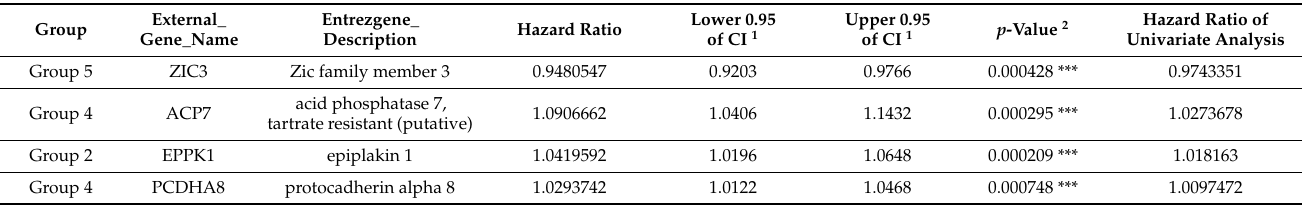
Table 2. Cox proportional-hazard analysis results of 66 candidate